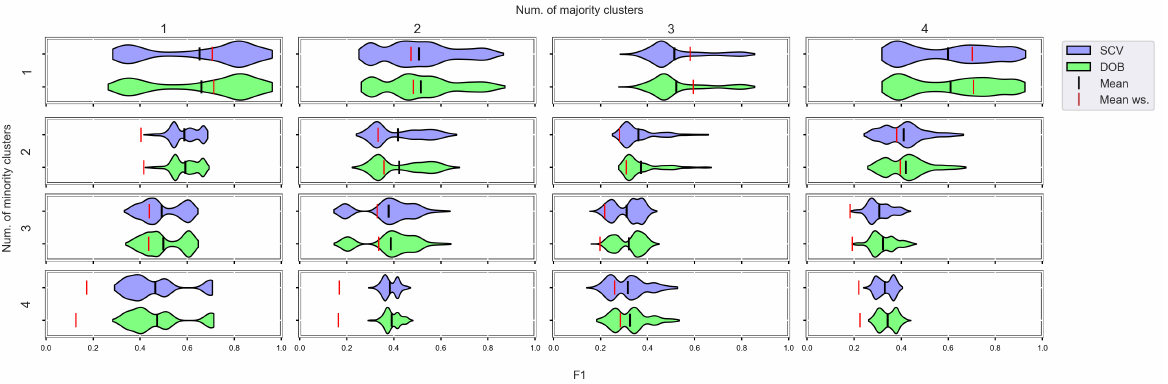
Figure 10. F 1 values concerning the number of clusters in the minority and majority classes in the case of the SVM classifier.